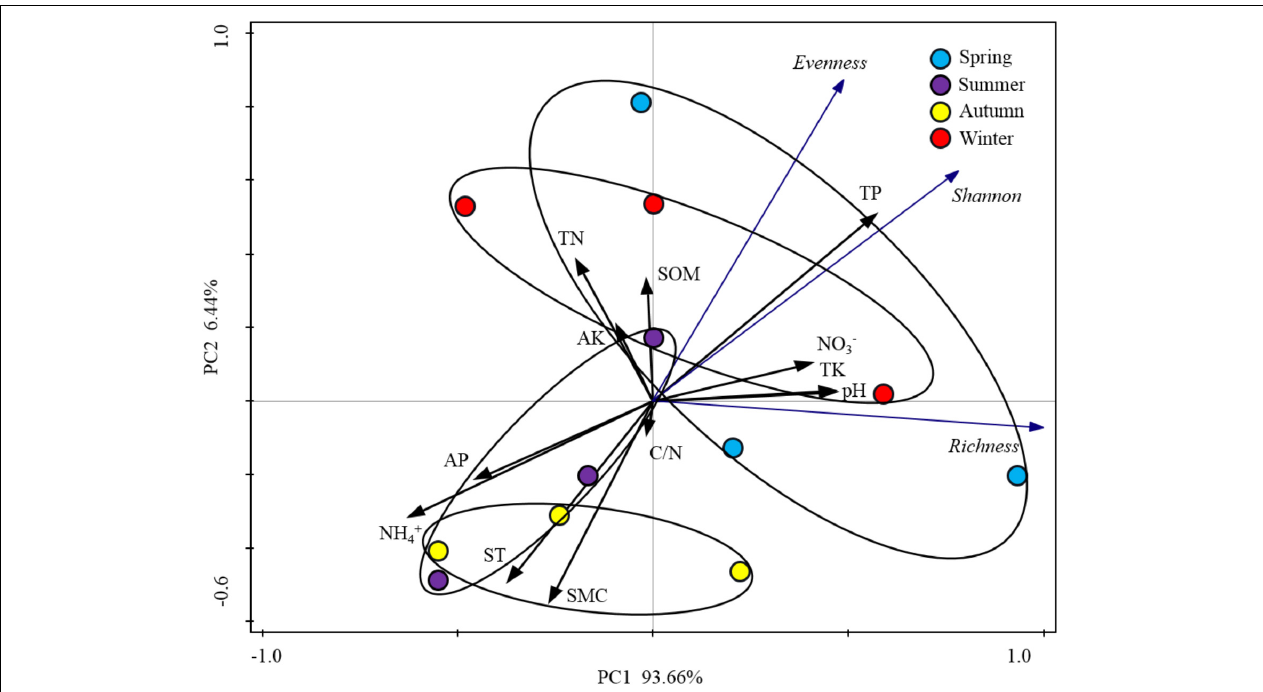
FIGURE 5 | Principal component analysis (PCA) based on the soil physicochemical characteristics of P . tabulaeformis forest as variables. Alpha-diversity indices were fitted as factors with significance < 0.05 onto the